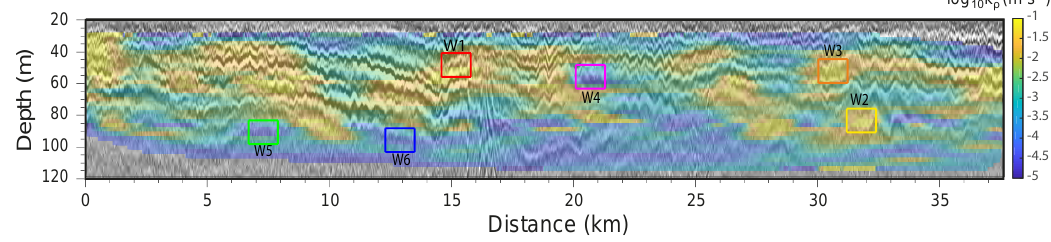
Figure 5. High-resolution k ρ (x,z) map overlapped with the HR-MCS image. Squares indicate location of some of the 1200m × 15m windows analyzed. They have been selected as examples of high-dissipation (windows W1–W3) and low-dissipation (windows W4–W6) areas. The color code of the squares is the same as for reflector spectra in Fig. 6, so that colors coincide with those of displacement spectra within the corresponding